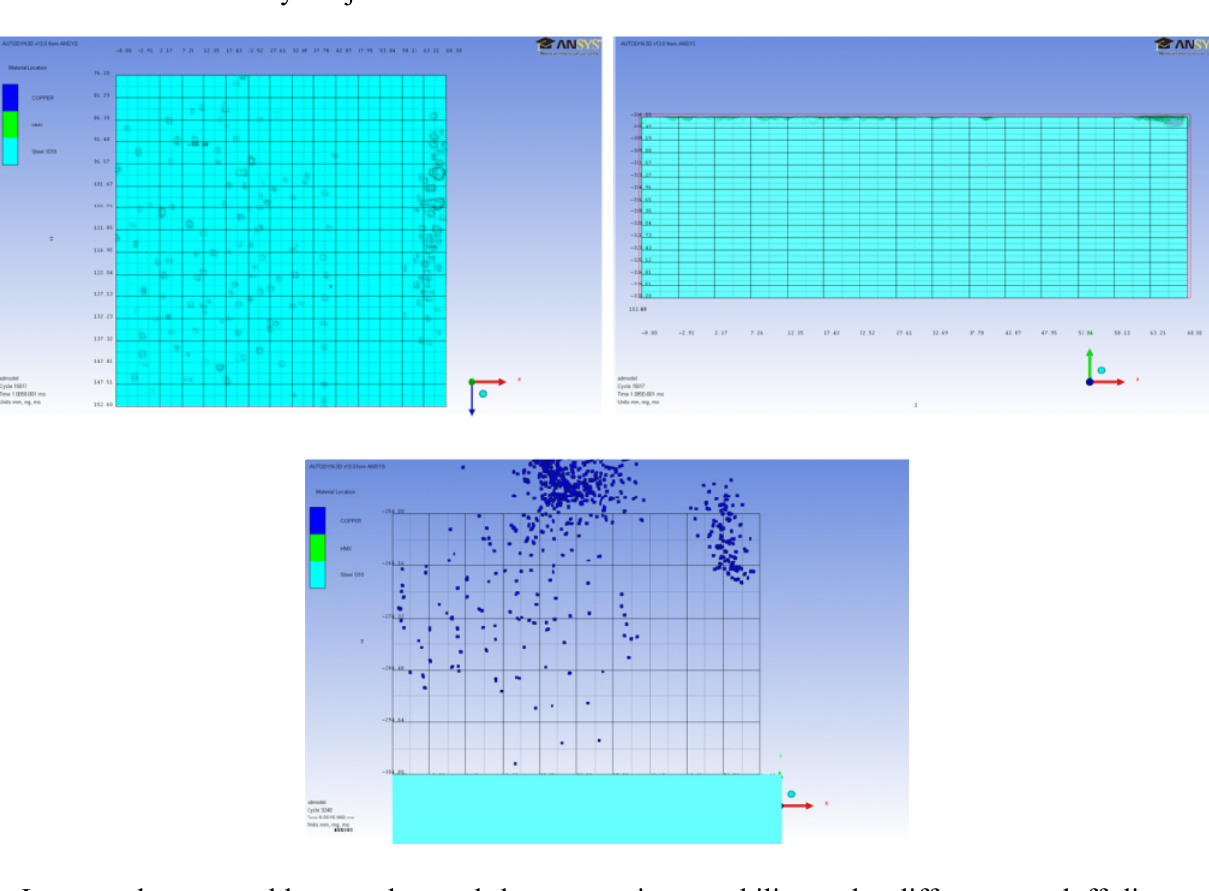
Figure 15. The penetration profile can be seen on the top of the target and in a cross section of the target at a 12 inches (30.48 cm) standoff distance after 15 µs (top left and top right pictures respectively). The bottom picture above shows the jet spreading due to the distance traveled by the